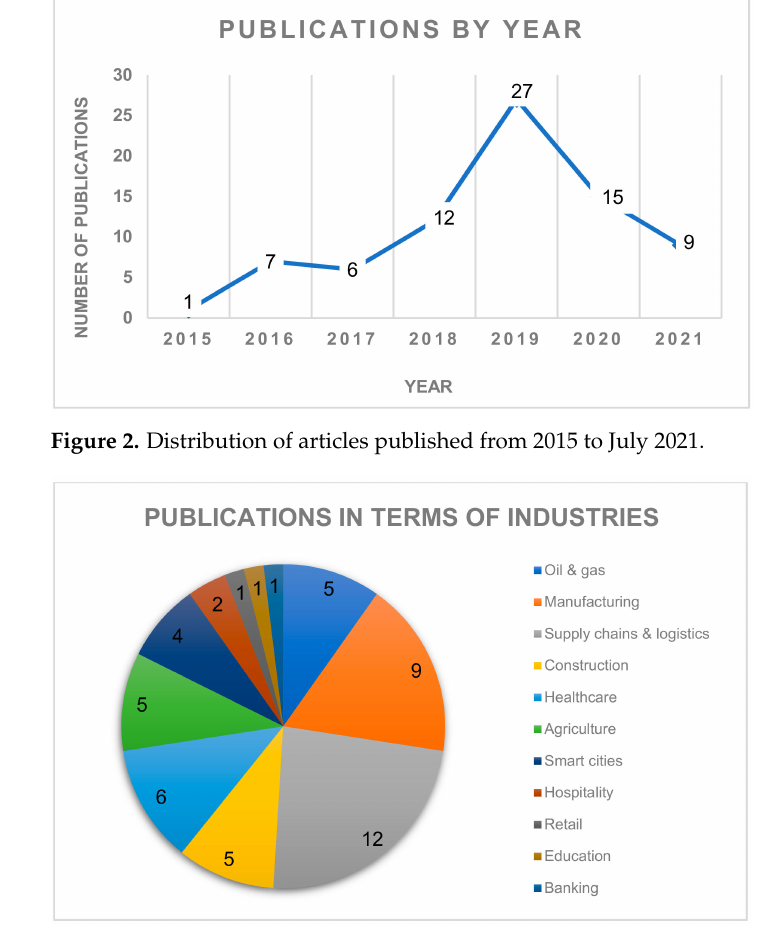
Figure 3. Distribution of articles in terms of